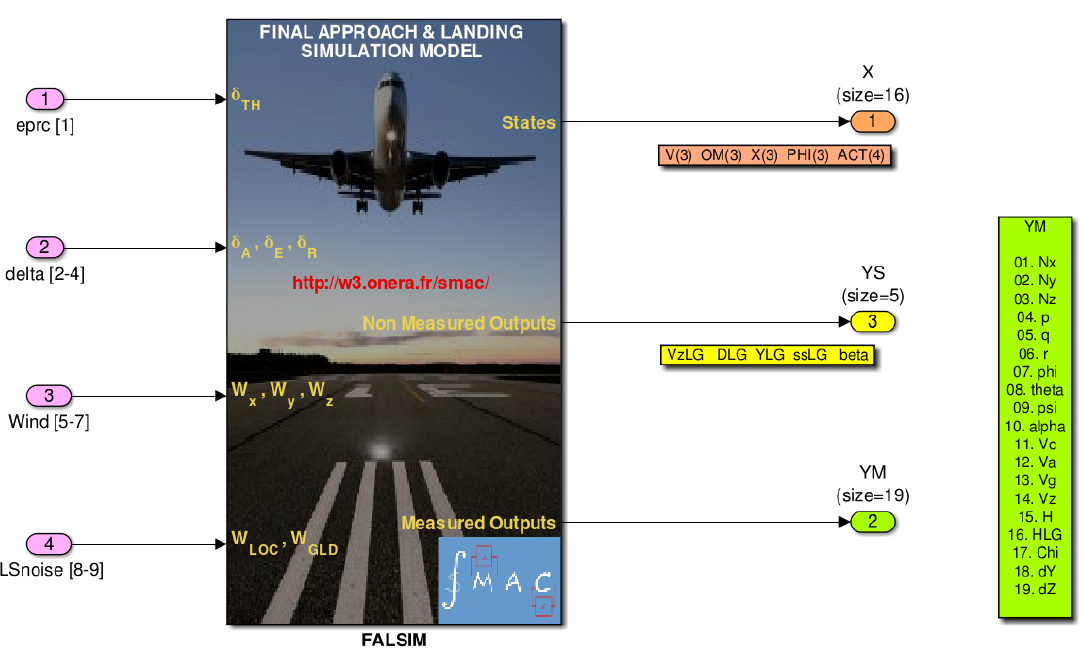
Figure A1. A general S IMULINK R (cid:13) view of the aircraft simulation